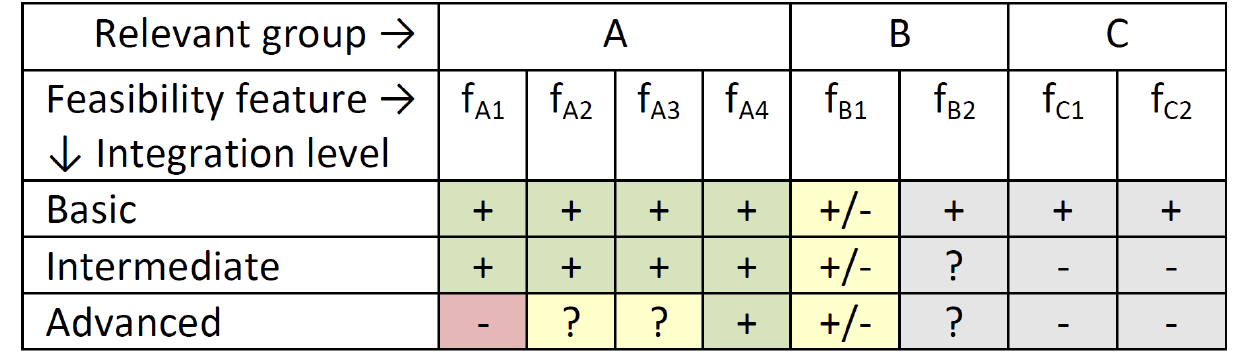
Figure 4. Evaluation profile for the VPH ARCH integration.